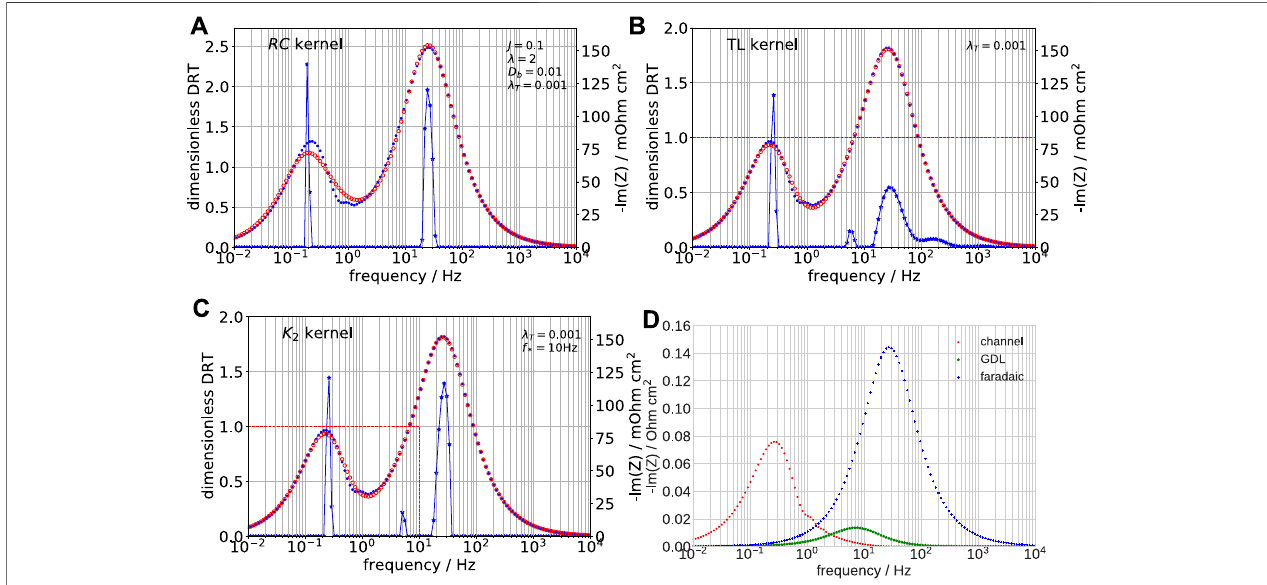
FIGURE 4| (A) DRT calculated with the RC kernel (solid line, left axis) using imaginary part of the total cathode side impedance, Appendix Eq. A6 (blue dots, right axis). Red open circles — Im ( Z tot ) reconstructed from the calculated DRT. (B) The same as in (A) curves obtained with the TL kernel ( α (cid:1) 1) over the whole frequency range. Red dashed line indicates the plot of α function, Eq. 14 . (C) The curves as in (A) obtained with the K 2 kernel and threshold frequency f * (cid:1) 10 Hz. ( D ) Separate imaginary parts of the channel, GDL, and faradaic impedance.